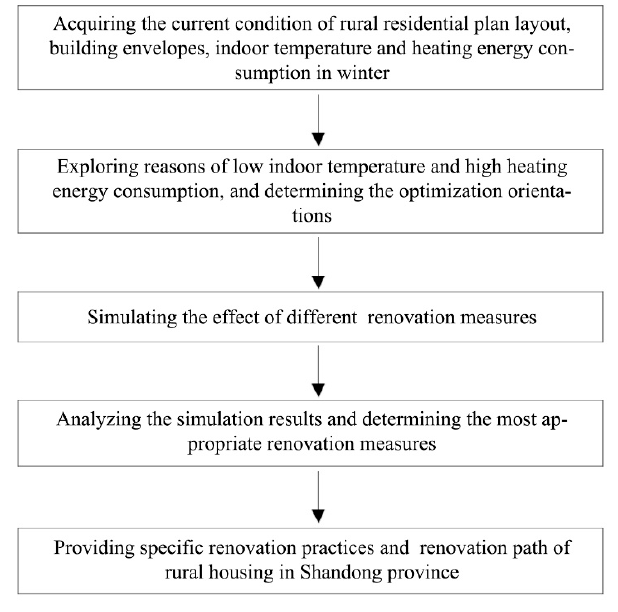
Figure 7. The flow for transforming a rural house.